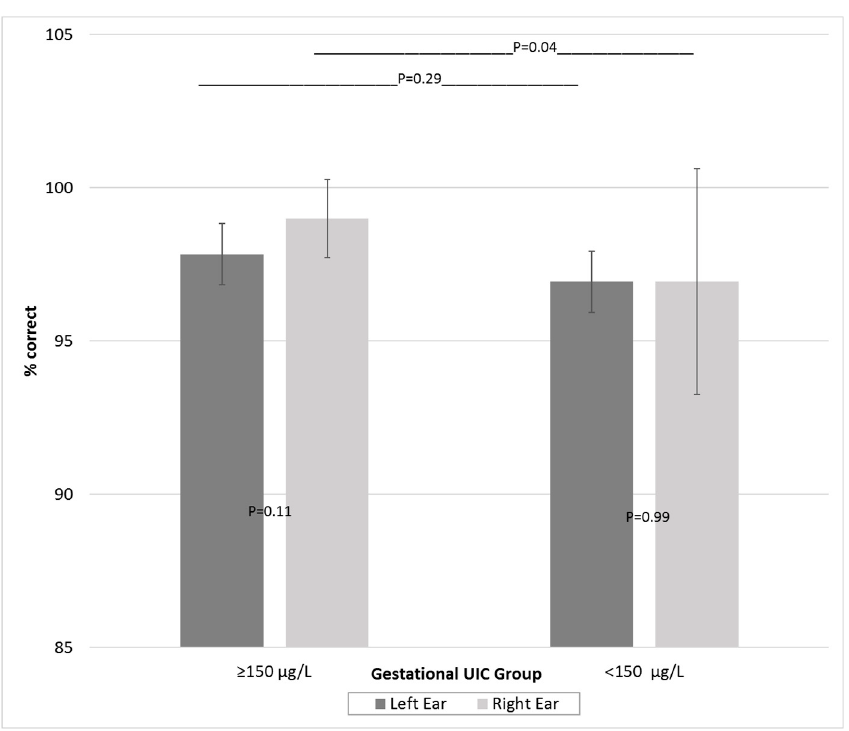
Figure 2. Dichotic digits test (mean and standard deviation): differences within and between groups. UIC